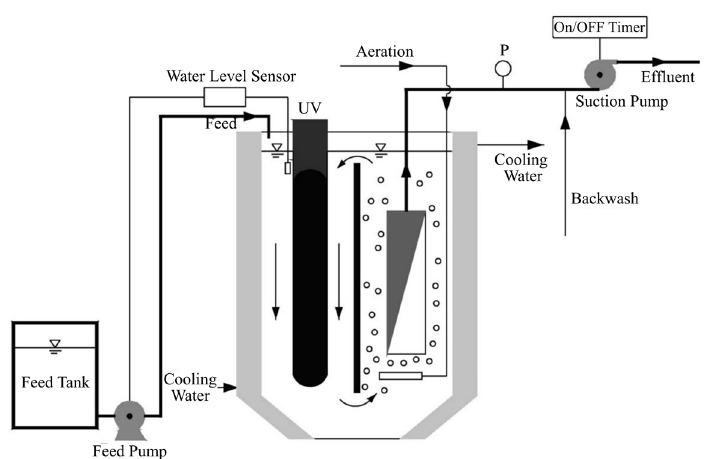
Figure 10. Schematic diagram of a typical lab-scale integrative PMR with UV lamps inside the reactor. Adapted with permission from [73], Copyright Elsevier, 2006.